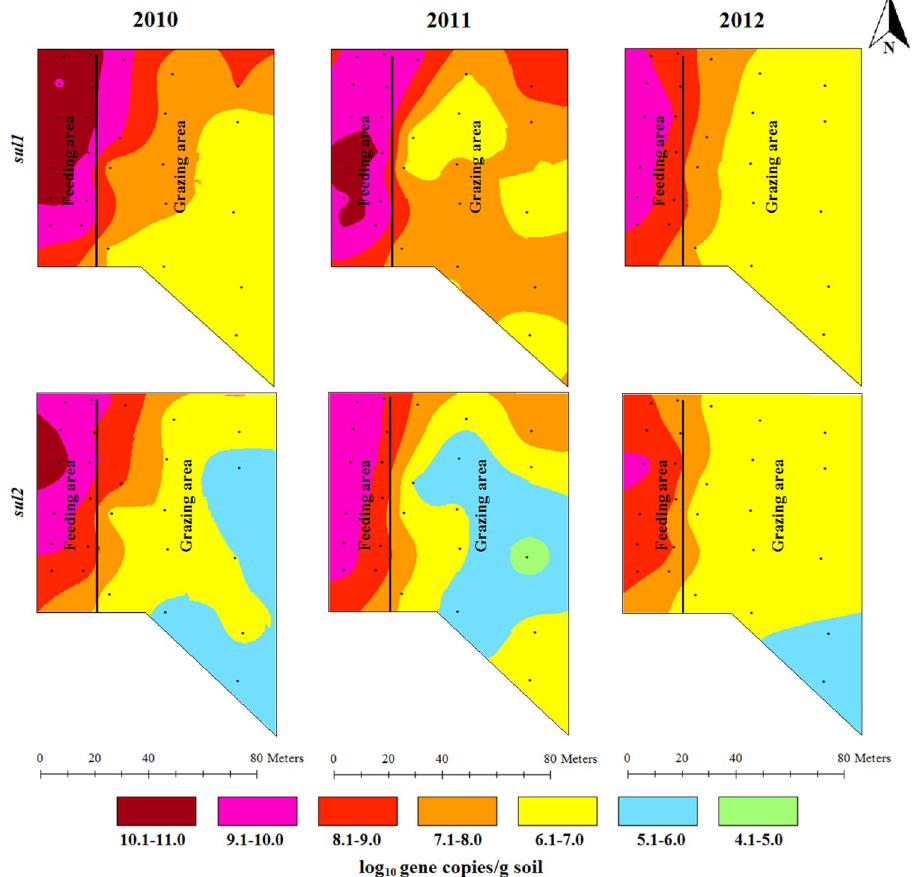
Fig 4. Spatial distributions of two sulfonamide resistance genes ( sul 1 and sul 2) concentrations in beef cattle backgrounding environment over two years after cattle removal.